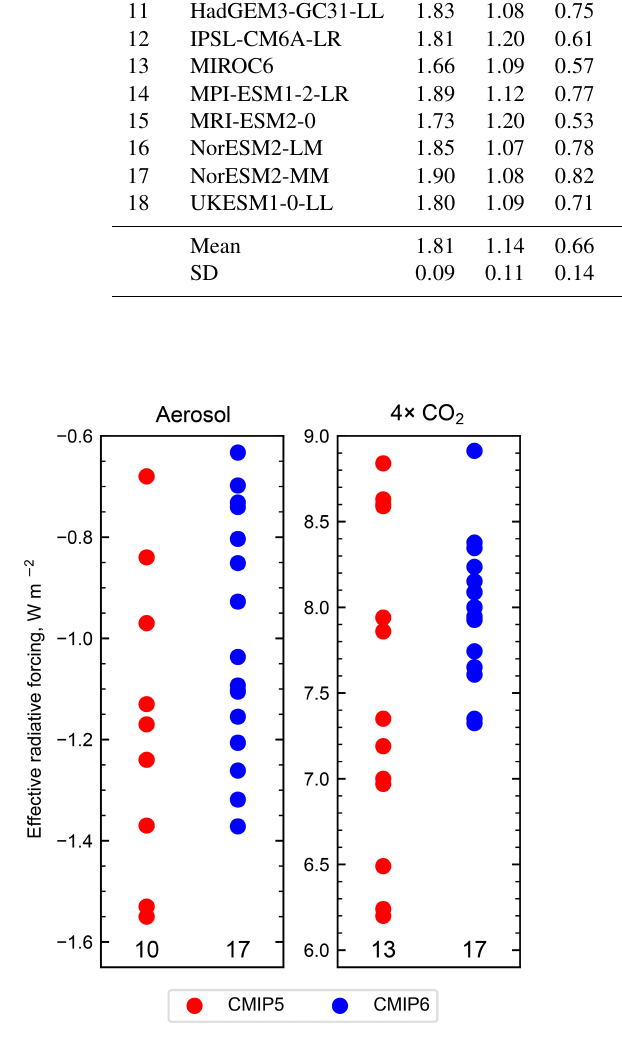
Figure 5. Aerosol and 4 × CO 2 effective radiative forcing from CMIP5 sstClim4xCO2 and sstClimAerosol experiments (Kamae and Watanabe, 2012; Zelinka et al., 2014) and CMIP6 RFMIP ex- periments. Numbers at the bottom of each plot give the number of participating